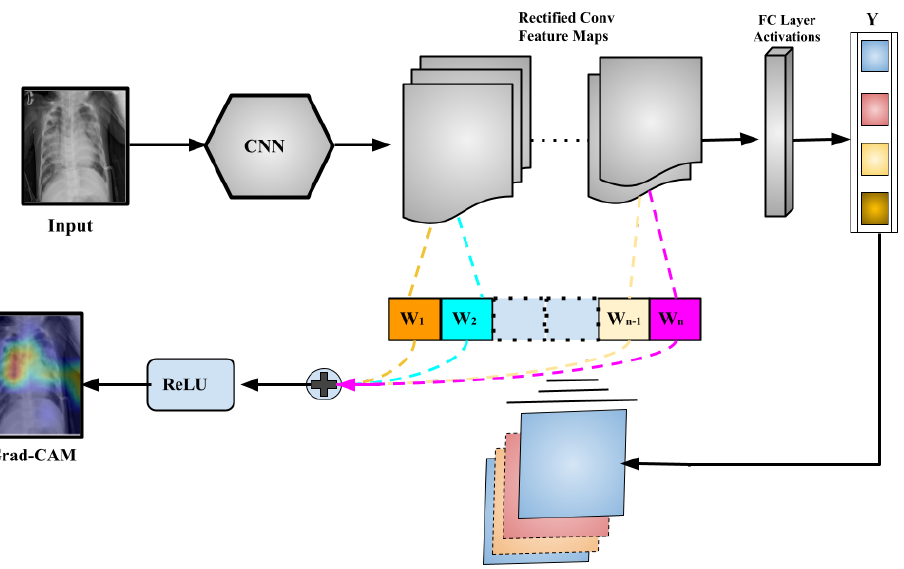
Figure 12. A general illustrative diagram of Gradient Weighted Class Activation Mapping (Grad-